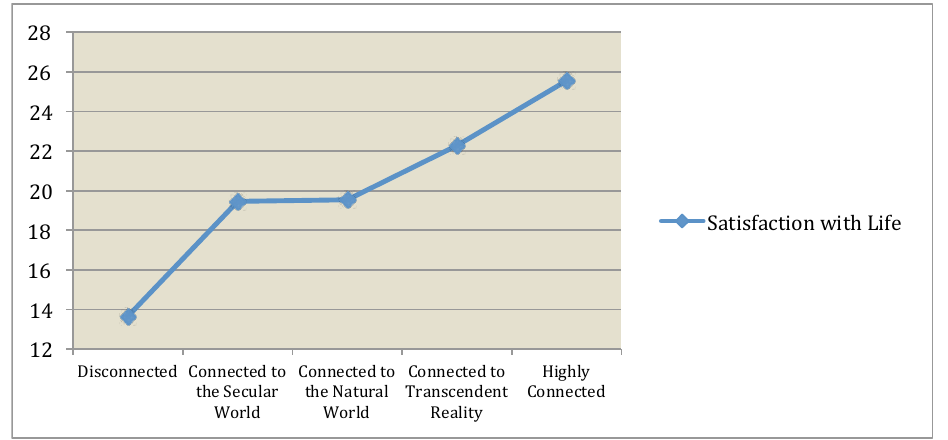
Figure 7. One-way ANOVA of mean satisfaction with life across five classes of spiritual connection, F =35.59*. * p < .01.